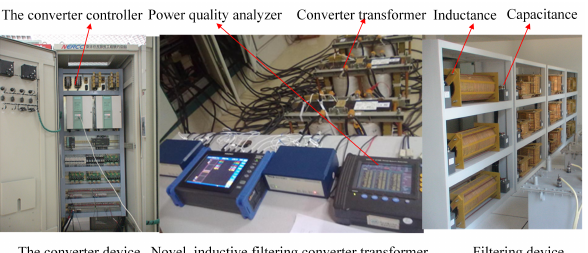
Figure 12. Wiring diagram of experiment for the integrated multi-winding inductive filter converter